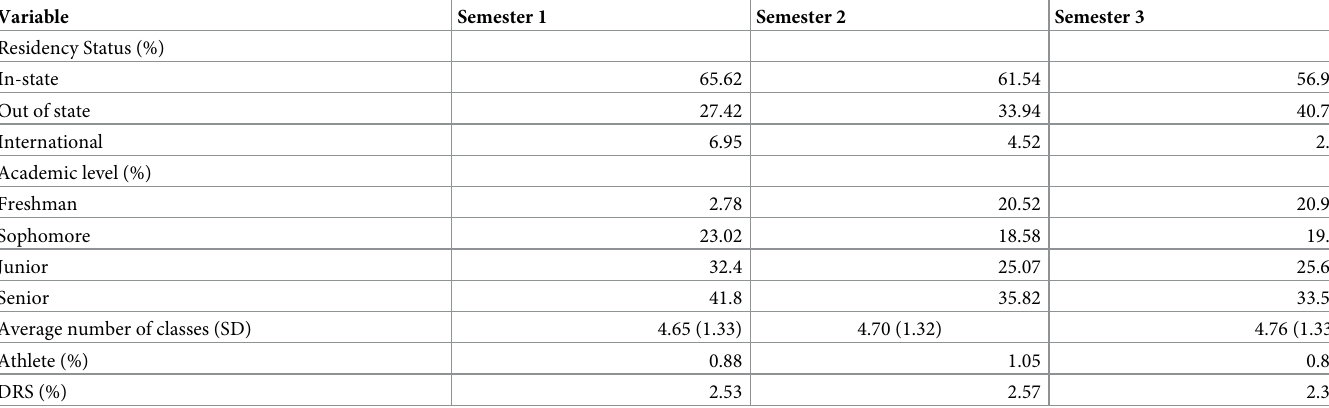
Table 2. Descriptive statistics for